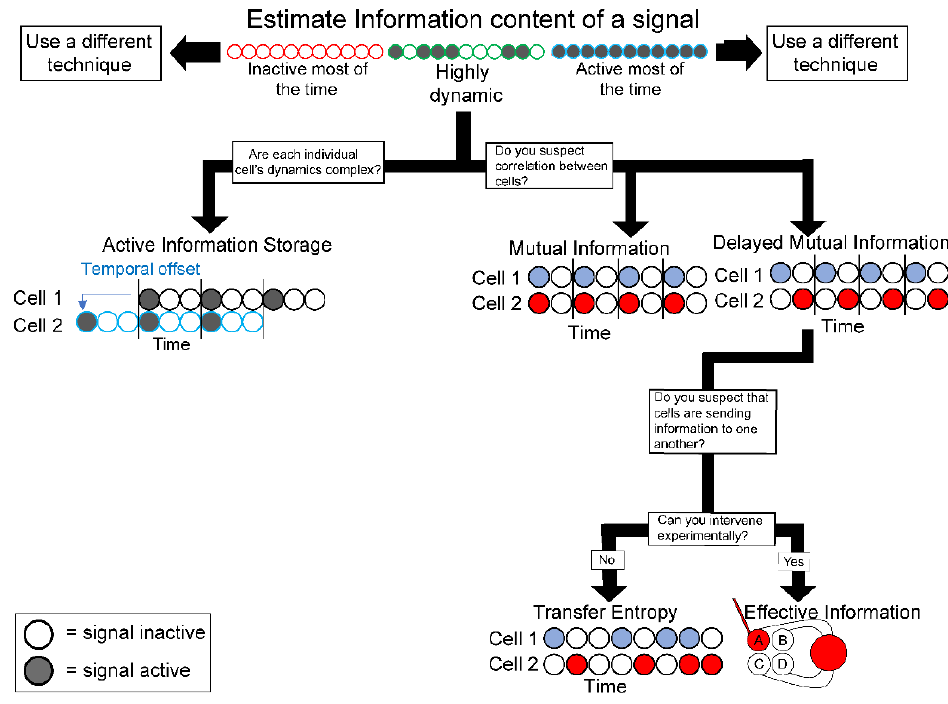
Figure 2. Information metric flowchart. Suggested workflow for deciding which information theory metrics to apply based on qualitative observations of a system.